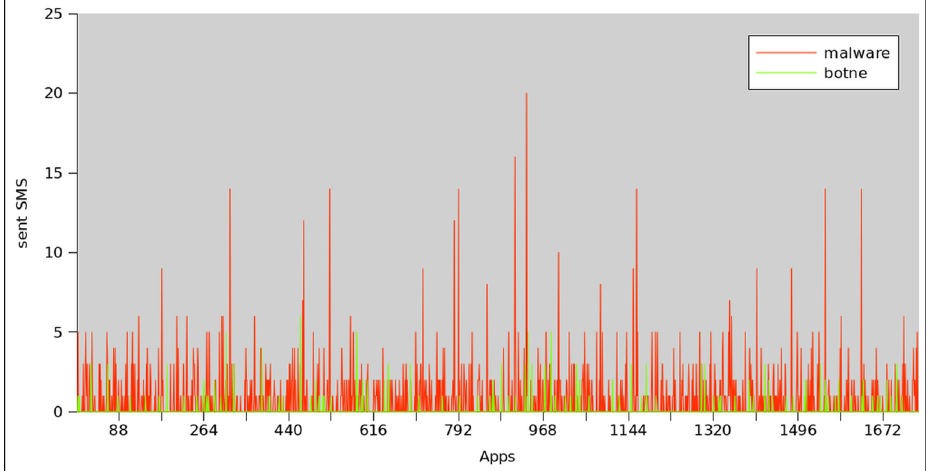
Fig 27. Sent SMS frequency Analysis between botnet and malware